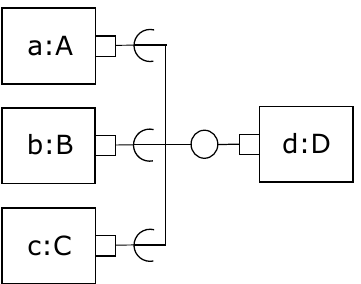
Figure 5. Multiple requesters connected to a single